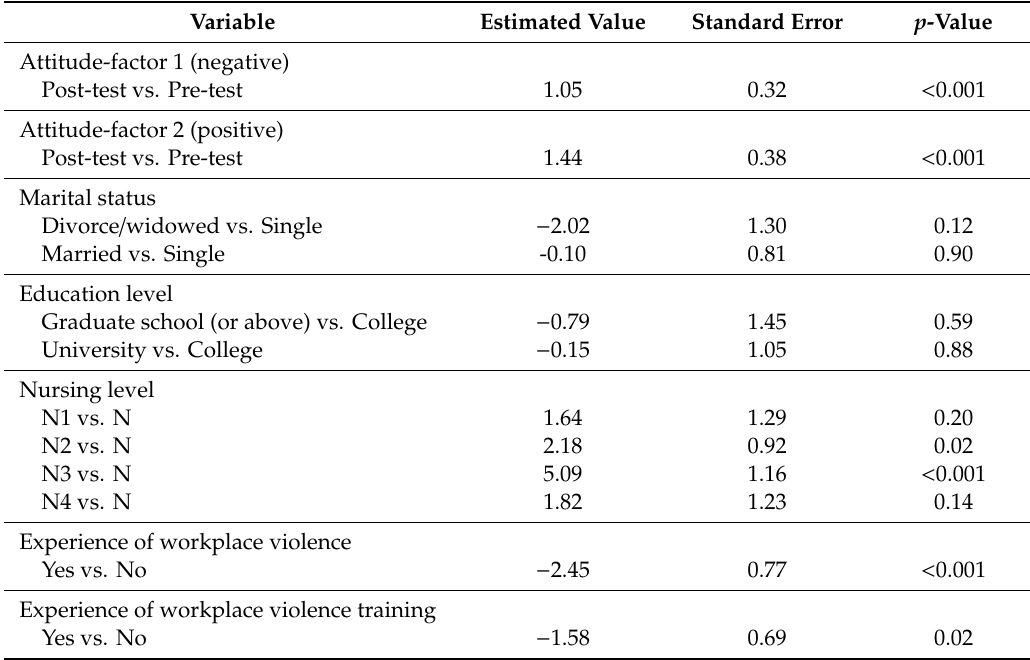
Table 4. Comparison of pre- and post-test of workplace violence